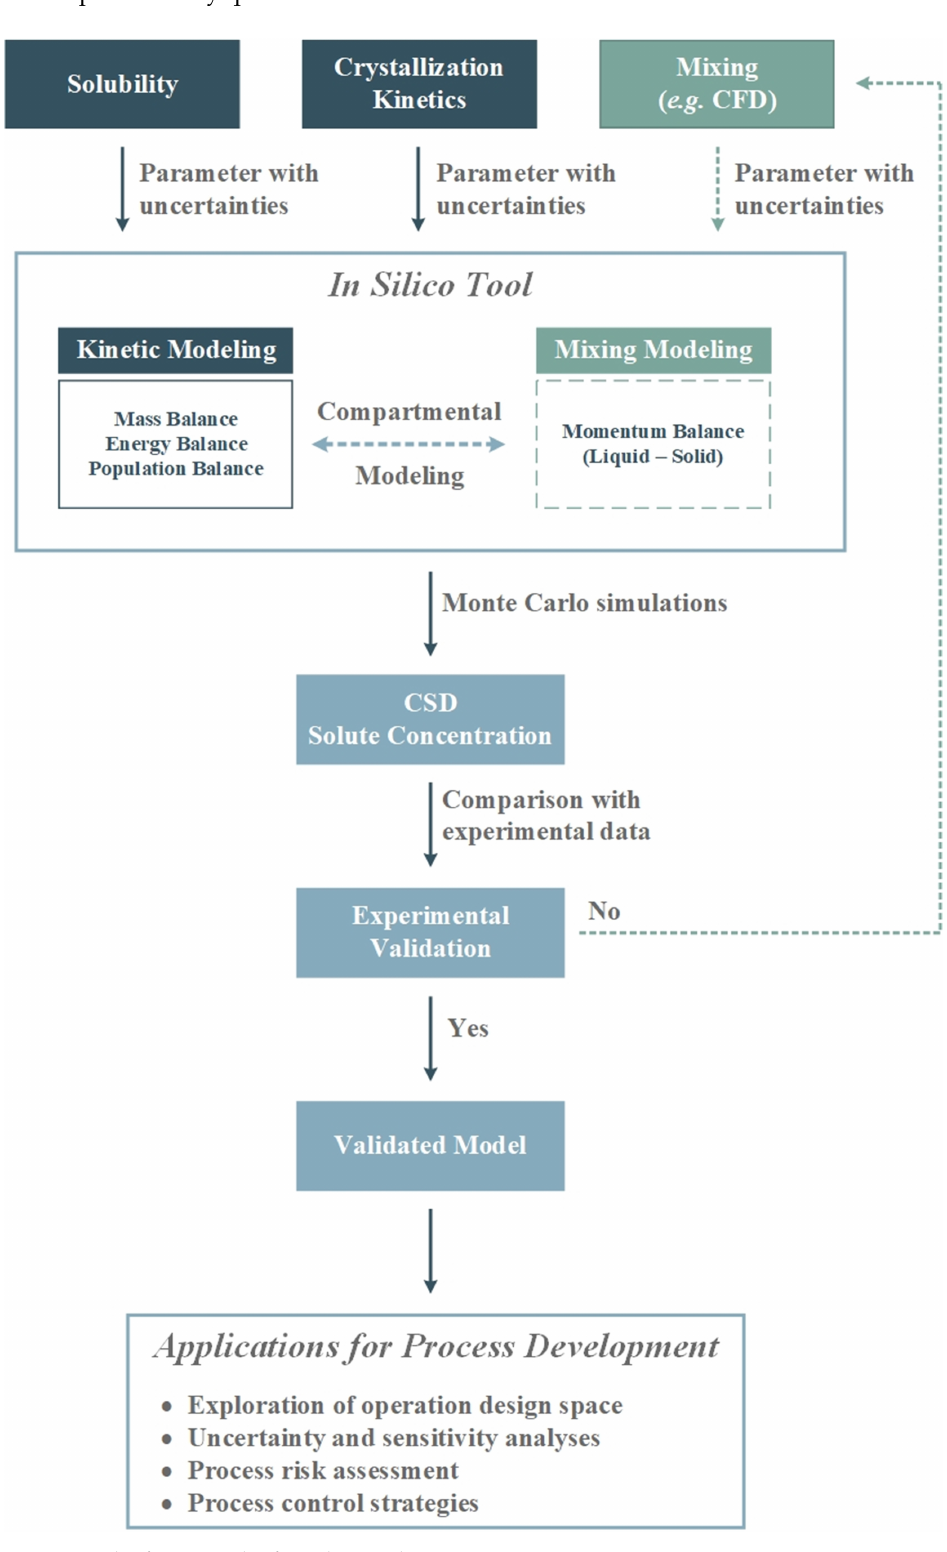
Figure 1. The framework of in silico